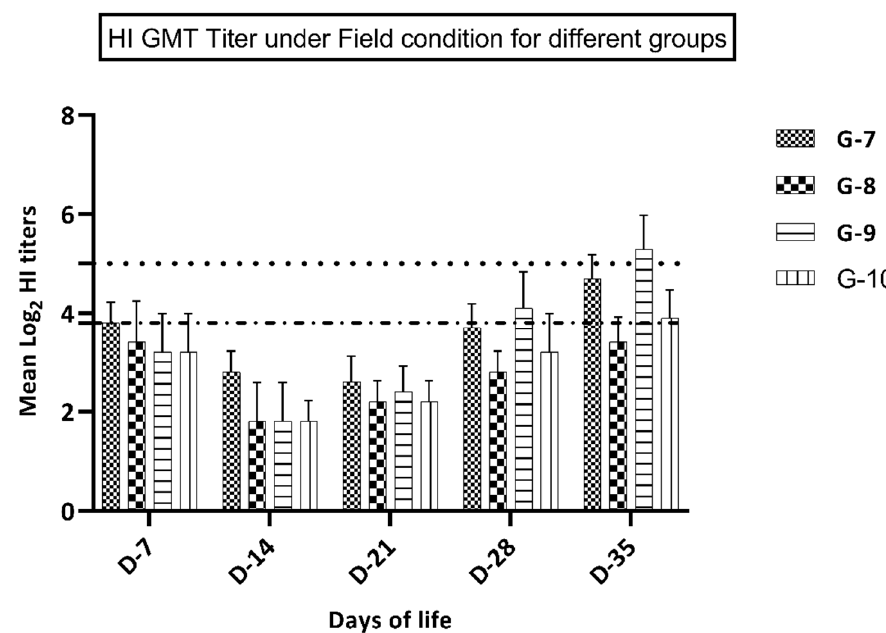
Figure 2. GMT HI titer in groups 7–10 (kept under field conditions).